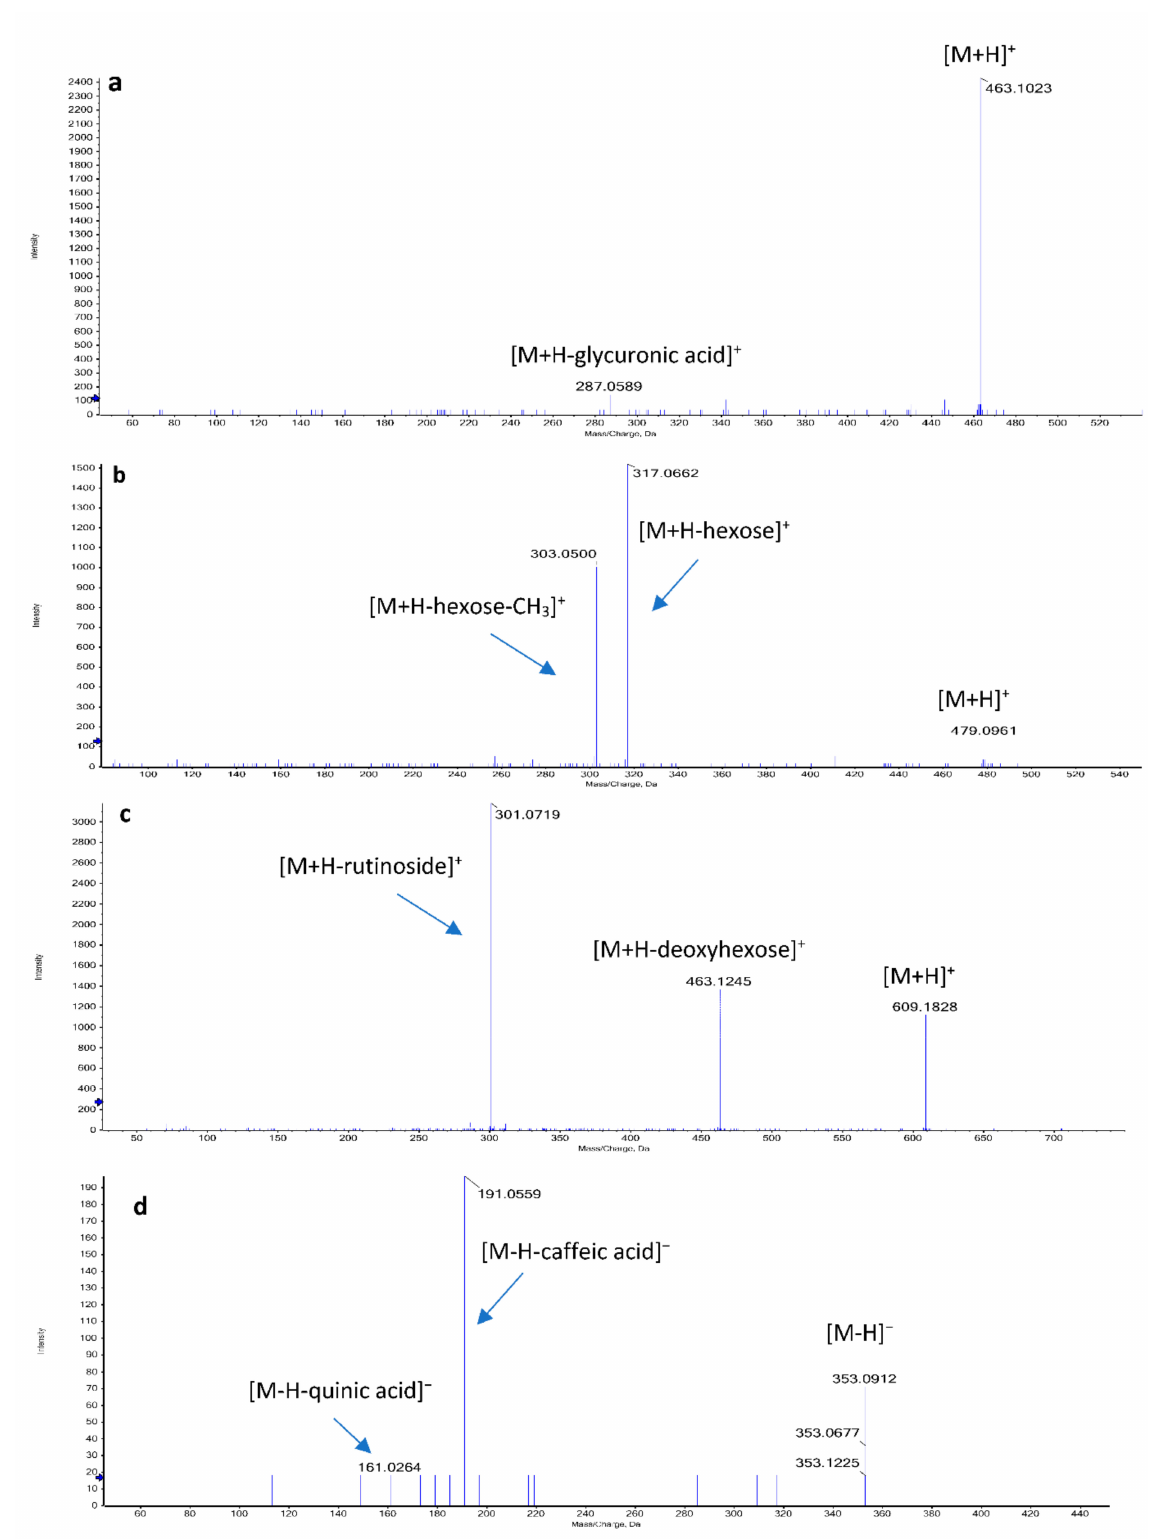
Figure 3. Mass fragments of some identified phytoconstituents in the methanol extract of Saussurea costus roots: ( a ) kaempferol glycuronide, ( b ) petunidin- O -hexoside, ( c ) diosmin, ( d ) and chlorogenic